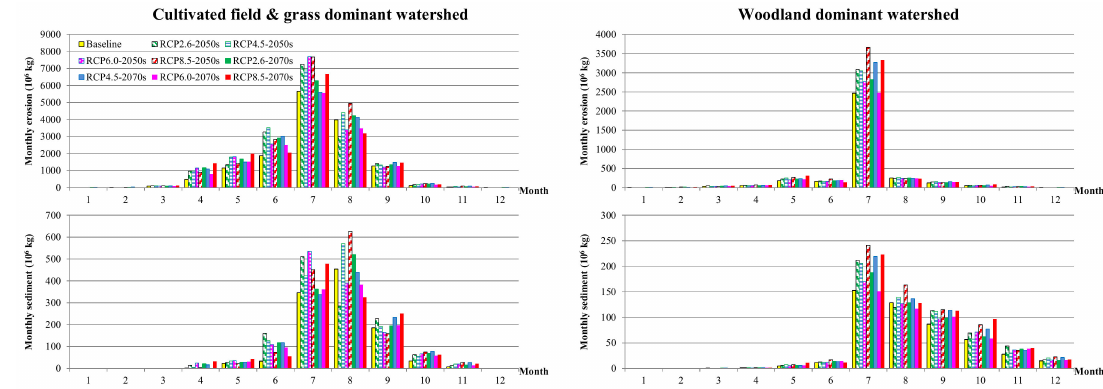
Figure 5. The changes in annual erosion and sediment in response to various future climate changes in the 2050s and 2070s. The upper and lower borders of the box represent the 25th and 75th percentiles; the line and cross in the box interior represent the median and mean values; the “whiskers” represent the lower and upper limits.